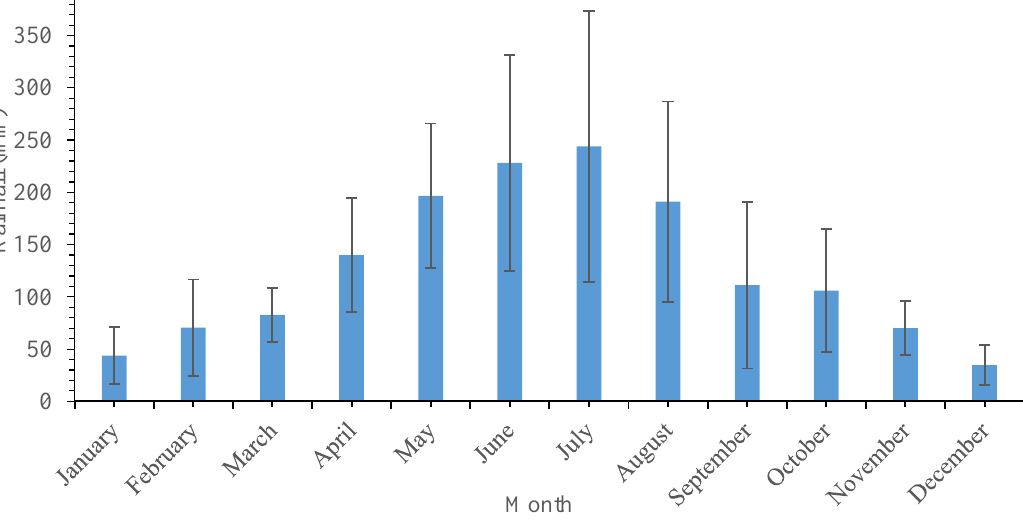
Figure 5. Annual rainfall in Nverzhai Basin, China.